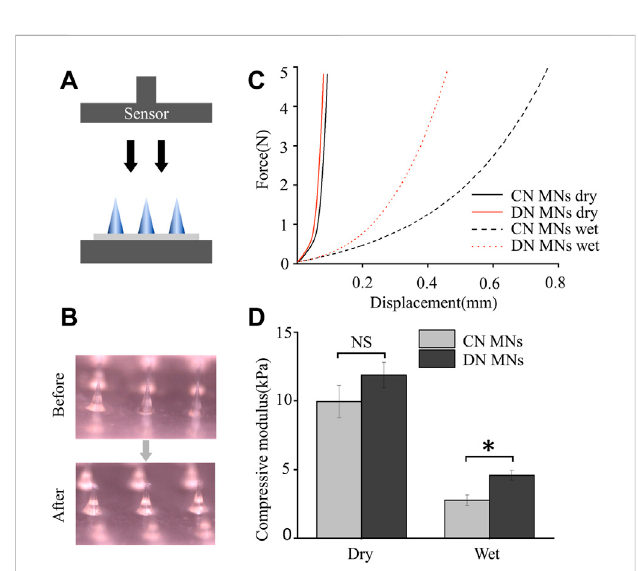
FIGURE 4 Mechanical property of the chemically crosslinked network MNs (CN MNs) and double-network MNs (DN MNs). (A) Schematics of the setupsfortestingmechanicalstrength. (B) OpticalimagesofthedryMNs before and after the mechanical strength test. (C) The mechanical strength properties of the MNs. For wet test, the MN tips were fi rst immersed in PBS solution for 10 s. (D) Quanti fi cation of the mechanical strength. The data are expressed as the means ± SD. ( n = 3). * p <